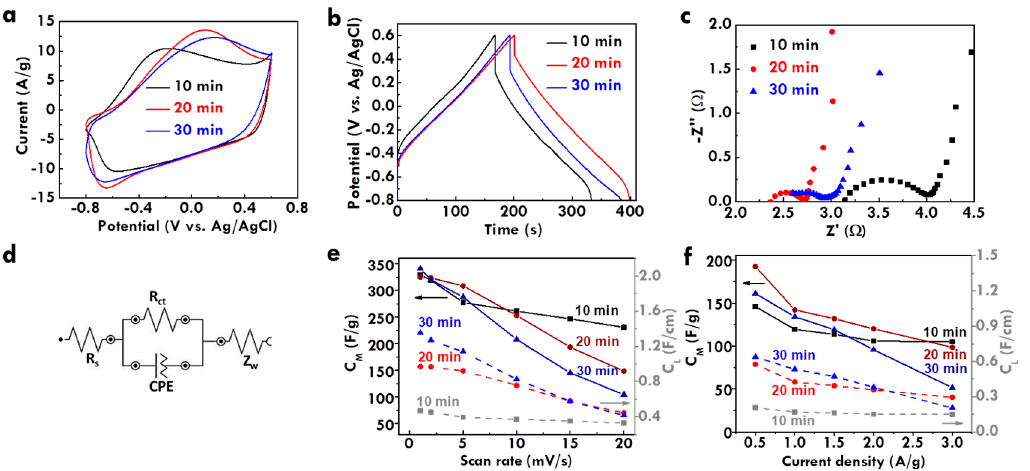
Figure 4. ( a ) CV curves at 5 mV/s, ( b ) GC/D curves at 1 A/g, ( c ) Nyquist plots and ( d ) equivalent circuit for ( c ), ( e ) relation between C F value and scan rate, and ( f ) relation between C F value and current density for CF@PPy electrodes prepared using different electropolymerization times.